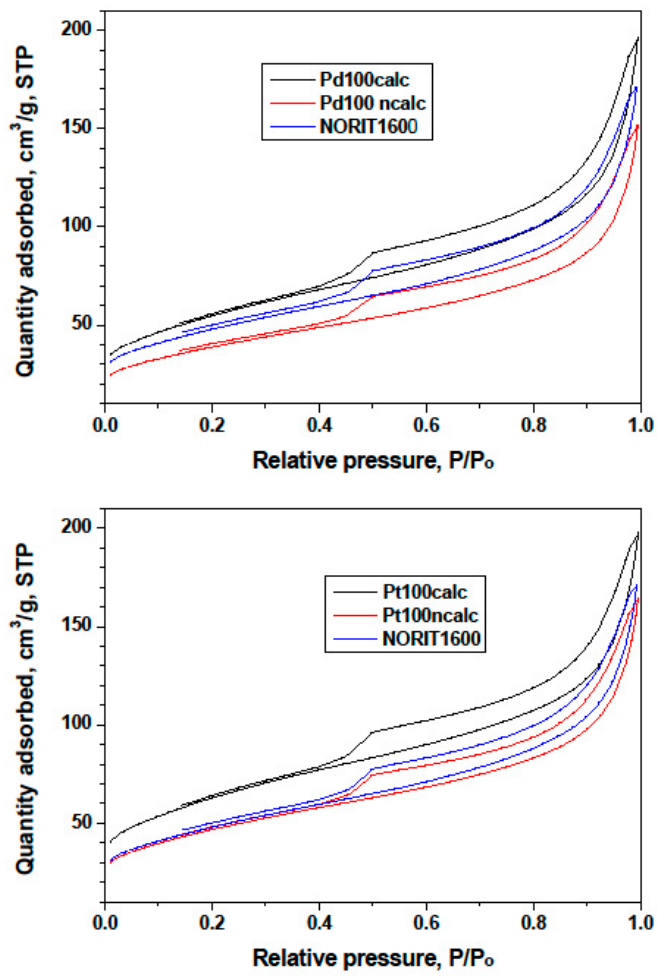
Figure 5. Physical adsorption–desorption isotherms of N 2 on Pd/Norit1600 (top) and Pt/Norit1600 (bottom). The isotherm for Norit1600 is included in the graphs.